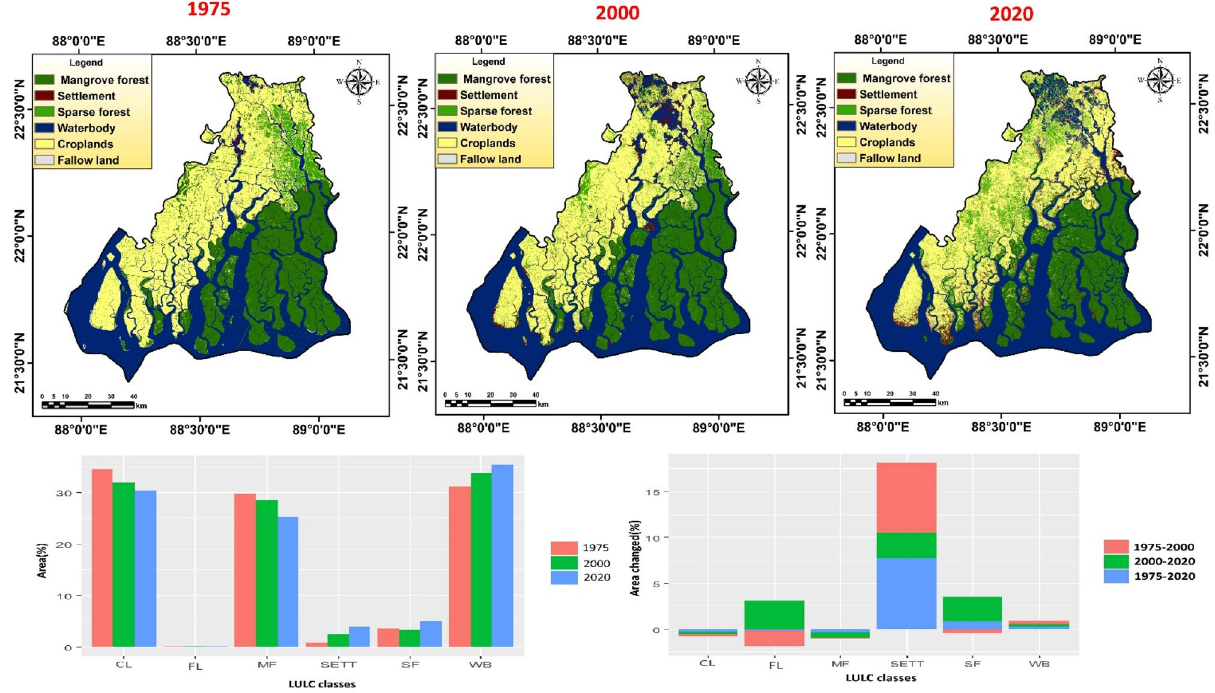
Figure 2. Land use land cover map (LULC) of various reference years (1975, 2000 and 2020) with respective LULC changes ( CL cropland, FL fallow land, MF mangrove forest, SETT settlement, SF sparse forest and